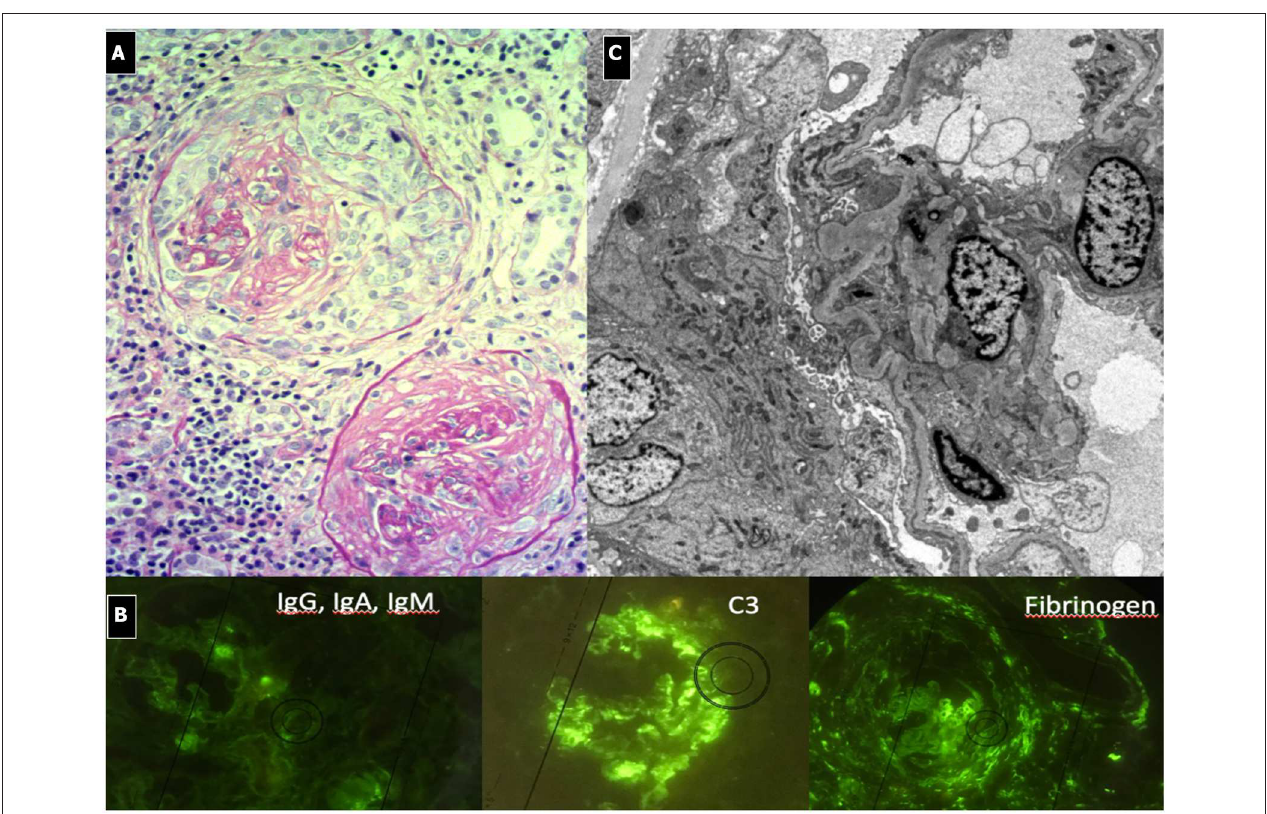
FIGURE 9 | ANCA Associated Vasculitis Nephritis. (A) Diffuse crescentic, sclerotic and focal necrotizing GN. Diffuse interstitial flogistic infiltration. One glomerulus is almost completely fibrotic. (B) pauci-immune IF pattern with evidence of fibrinogen deposition due to diffuse hyalinosis. C3 focal deposition. (C) EM, diffuse sclerosis. RAPIDLY PROGRESSIVE